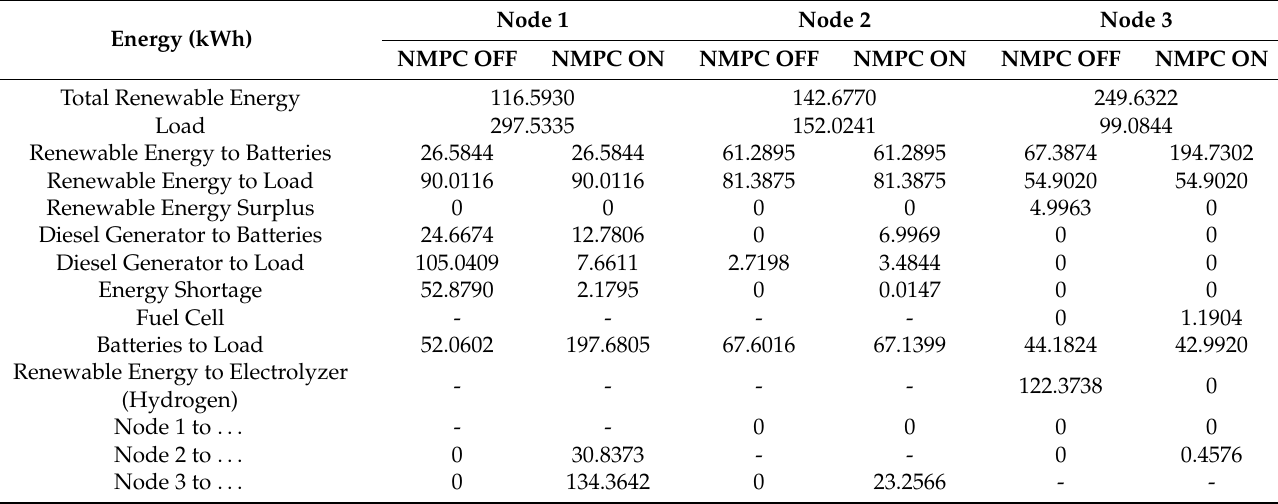
Table A3. Comparative results from Scenario 3—Weekly—Long term operation. Energy